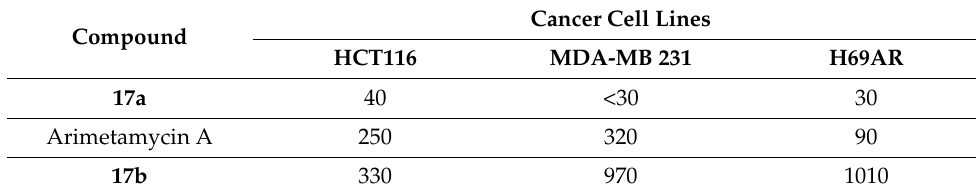
Table 4. TC 50 (nM) values of compounds 17a-b against three cancer cell lines.